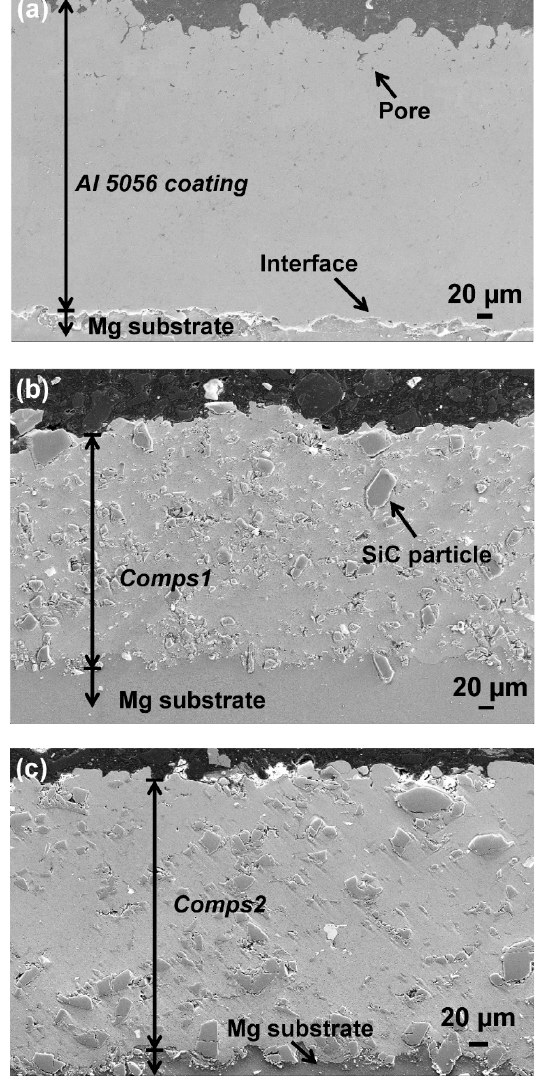
Figure 2. Cross-sectional SEM micrographs of the Al 5056 coating ( a ) and SiC p /Al 5056 composite coatings reinforced by different sizes of SiC particles: ( b ) Comps1 coating and ( c ) Comps2 coatings. The coatings reveal full, dense microstructures, such as those observed with the Al substrate. No visible connective porosity through the coating from the top to the interface coating/substrate can be observed. The SiC particles and a small quantity of pores are distributed homogeneously throughout. The Al 5056 particles are fully deformed as their original spherical shape can no longer be identified. The SiC particles retain their irregular morphology as before the deposition. There is no fracture of these particles as we had observed for bigger hard particles [30]. At the interface, there are neither cracks nor delamination.